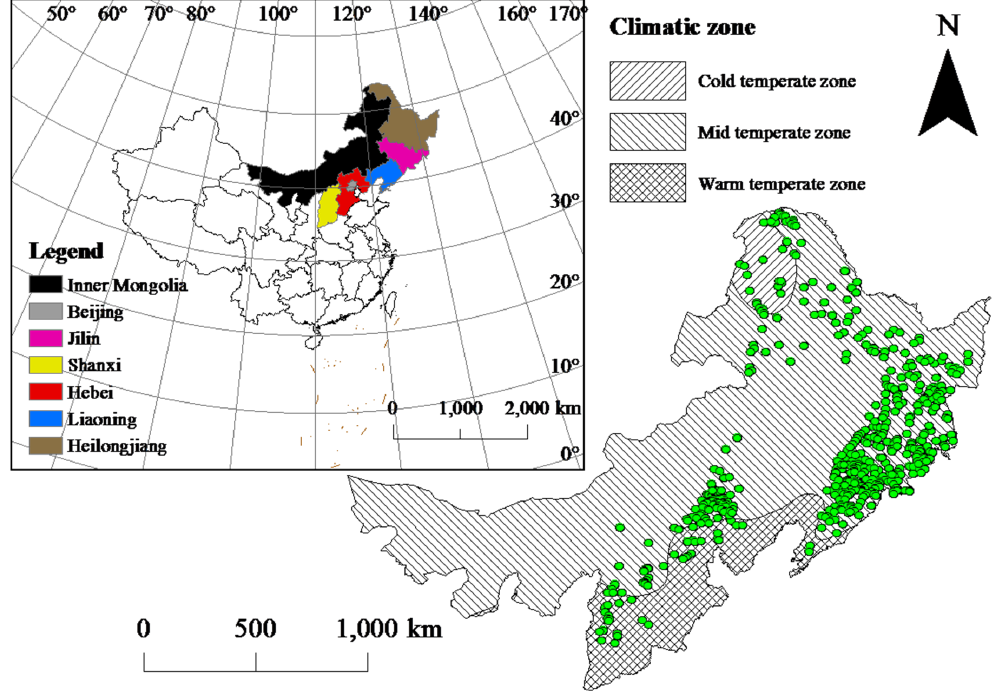
Figure 1. The distribution of plots. Latitude and longitude ranged from 34°34 ′ N to 53°33 ′ N and 97°12 ′ E to 135°05 ′ E, respectively; the geographic coordinate system of this map was GCS_Clarke_1866. Table 1. Summary of dominant height data by province.